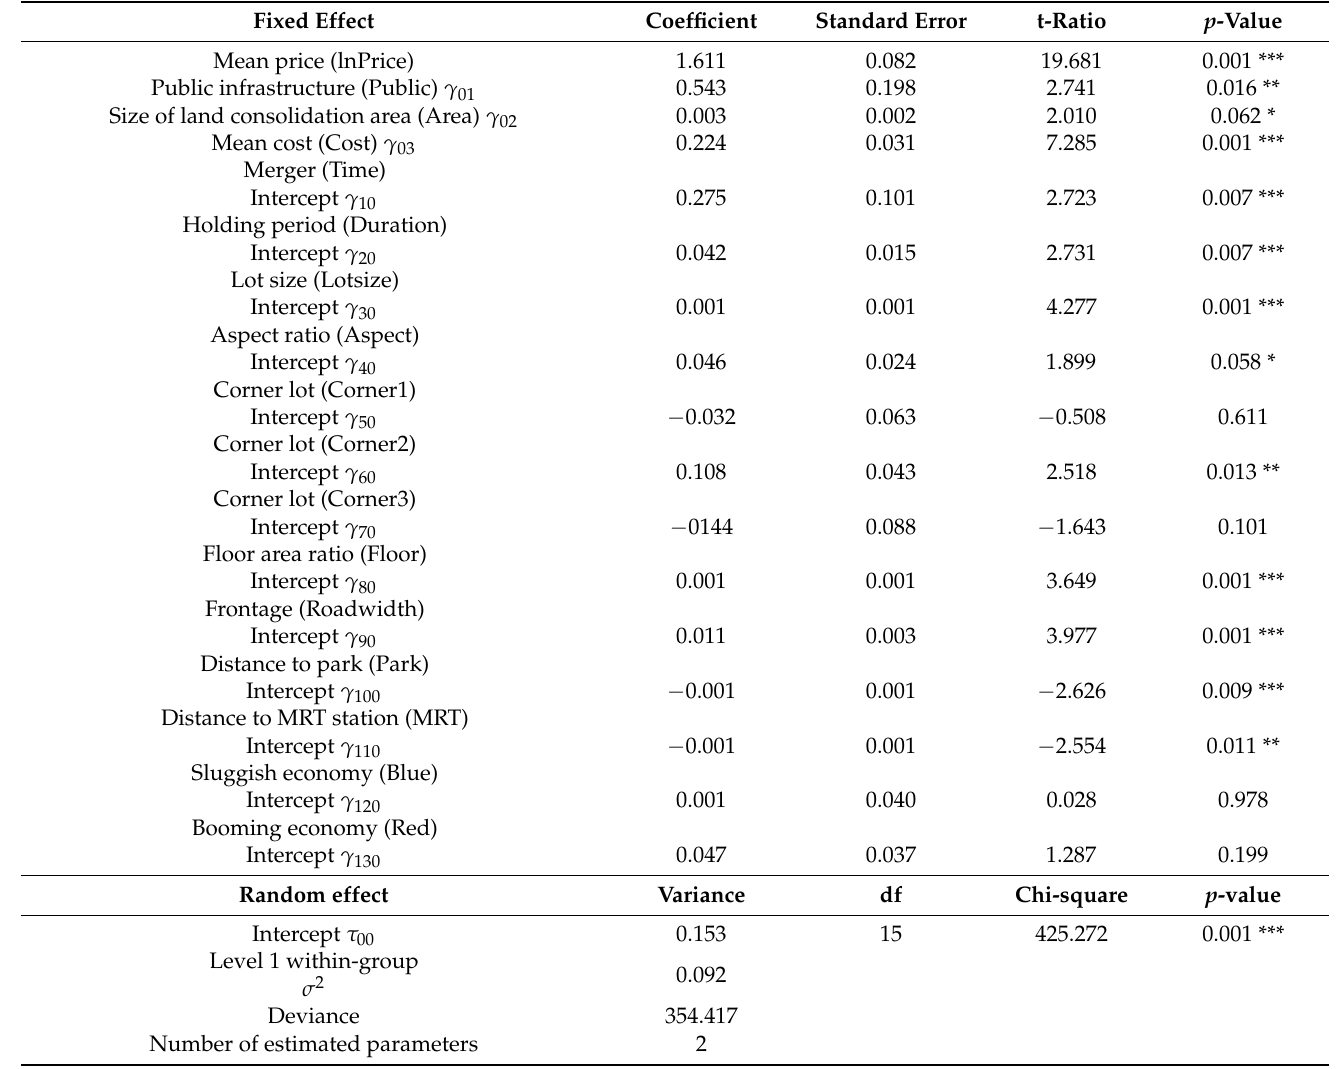
Table 5. Estimation results of the intercepts- and slopes-as-outcomes regression